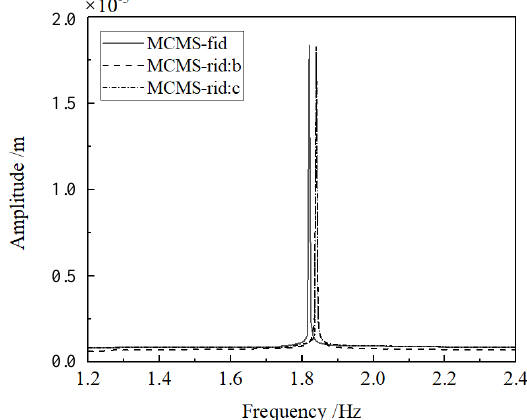
Figure 17. Frequency response functions of the beam by FE model, MCMS-fid and MCMS-rids with different interpolation schemes for the first